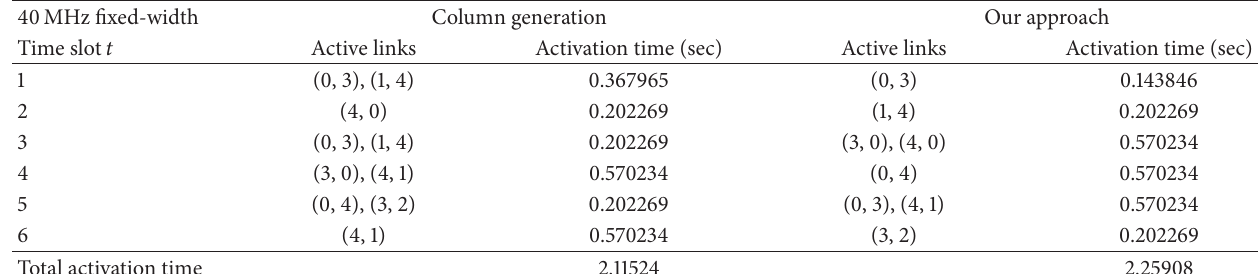
Table 3: Result of 40 MHz fixed-width channel